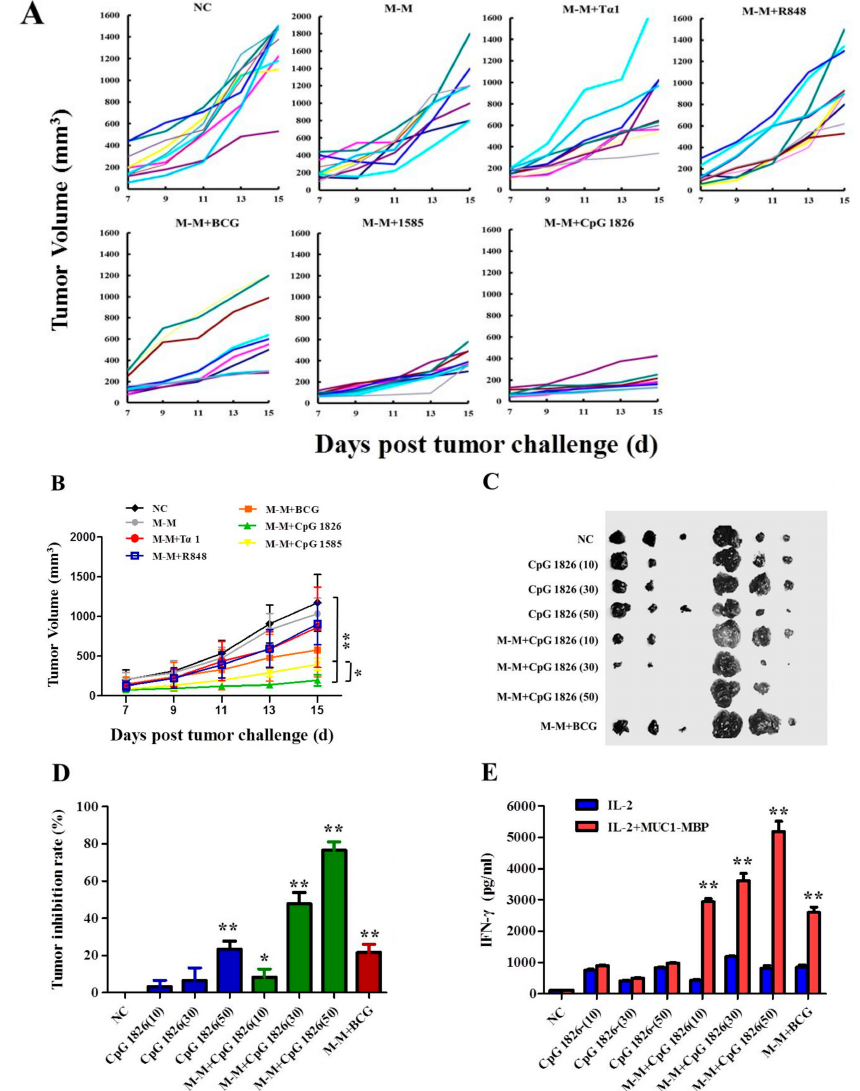
Figure 1. Anti-tumor effect of different adjuvants combined with M-M. ( A ) The anti-tumor effect of different adjuvants combined with M-M. Mice were divided into seven groups, and each group ( n = 10) were immunized as followings: M-M, M-M + T α 1, M-M + R848, M-M + BCG, M-M + CpG 1585, M-M + CpG 1826, or PBS on day –21 and –7 and were then subcutaneous injected (s.c.) with 2 × 10 6 B16- MUC1 melanoma cells on day 0. Each line represents the tumor growth kinetics in each mouse. ( B ) The mean tumor growth curves are given by tumor volume. ( C ) The dose effect of CpG 1826 on the growth of B16- MUC1 melanoma. Eight group of mice ( n = 6) were immunized two times with CpG 1826 10, 30, and 50 µ g alone or in combination with M-M (50 µ g). M-M + BCG represent M-M combined BCG. The mice were sacrificed on day 24 after tumor inoculation (5 × 10 5 B16- MUC1 melanoma cells). ( D ) The tumor inhibition rate. Tumor inhibition rate (%) = (1 − experimental group total tumor weight/control group) × 100%. ( E ) Splenocytes obtained from the immunized mice with different dose of CpG 1826. The production of IFN- γ was detected in splenocytes supernatants stimulated by IL-2 or IL-2 + MUC1-MBP. Six mice per group were analyzed. * p < 0.05, ** p < 0.01 vs. the negative control (NC)